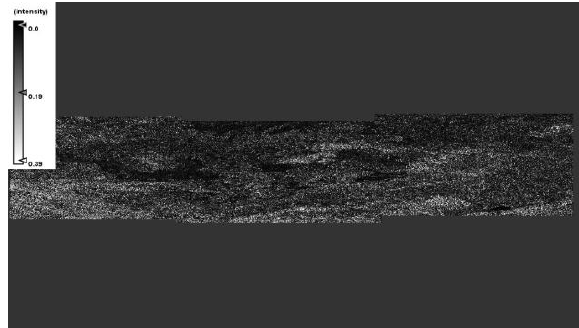
Figure 5. TOPSAR Deburst Rectificated View